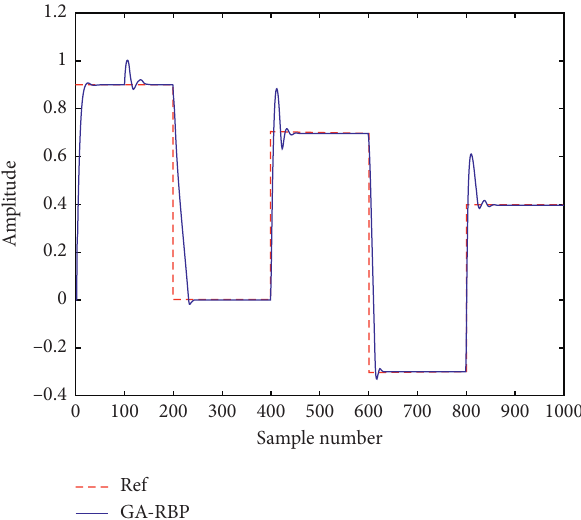
Figure 10: Tracking performance of the proposed algorithm on System II under external disturbance.